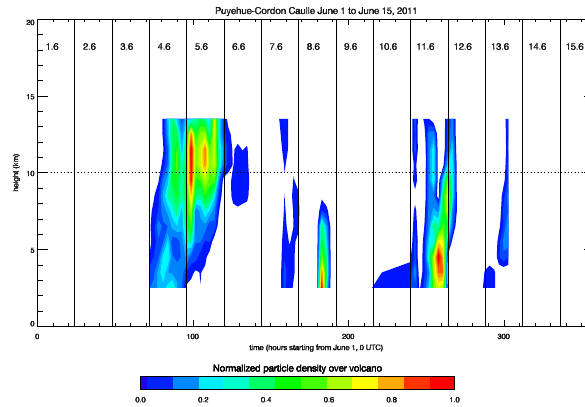
Fig. 7. Normalized trajectory density above PCC from 1 June to 15 June as indicator for the effective emission height of the volcanic ash derived by applying a source–receptor analysis using ensembles of backward trajectories.